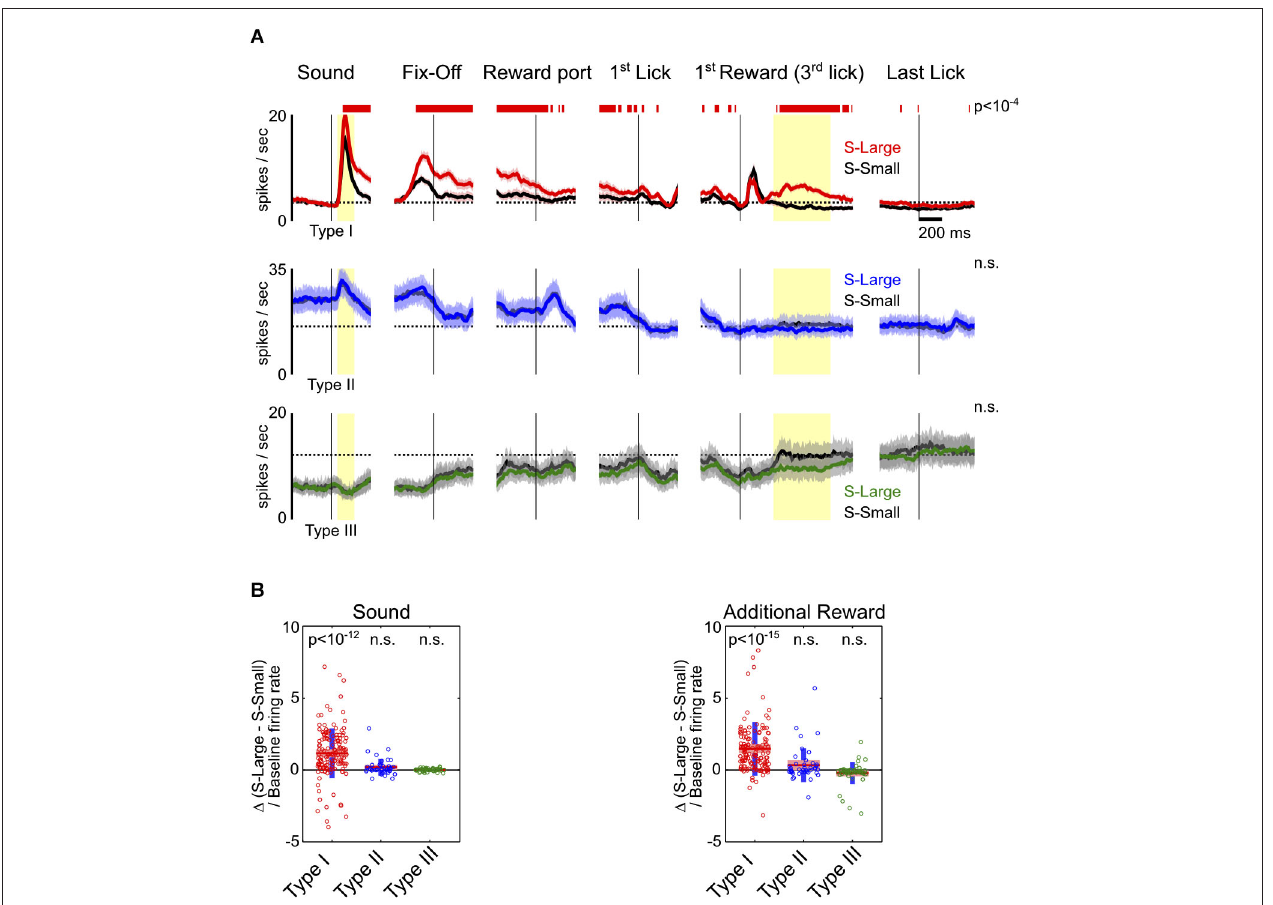
relative difference of response amplitudes between the two trial types at sound onset and the 2nd–4th rewarded licks. Time windows for analysis indicated by yellow shaded areas in (A) . Type-I BF neurons showed stronger responses to S-Large and to additional reward ( t -tests for significant differences from zero). Other neuron types did not show preference for either S-Large or S-Small